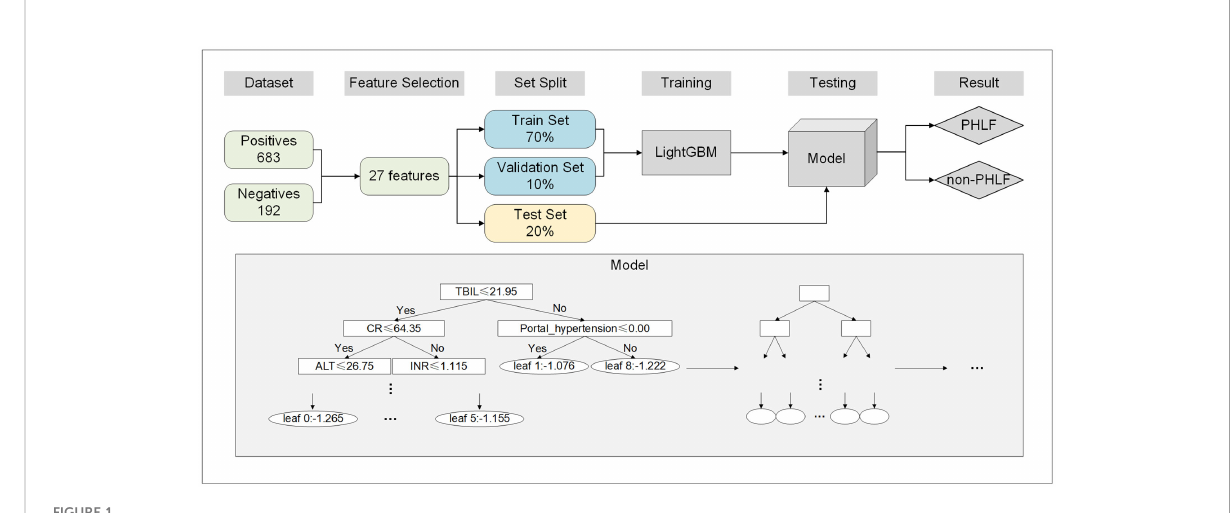
FIGURE 1 Flowchart of the development of the ML model. ML, machine earning; PHLF, post-hepatectomy liver